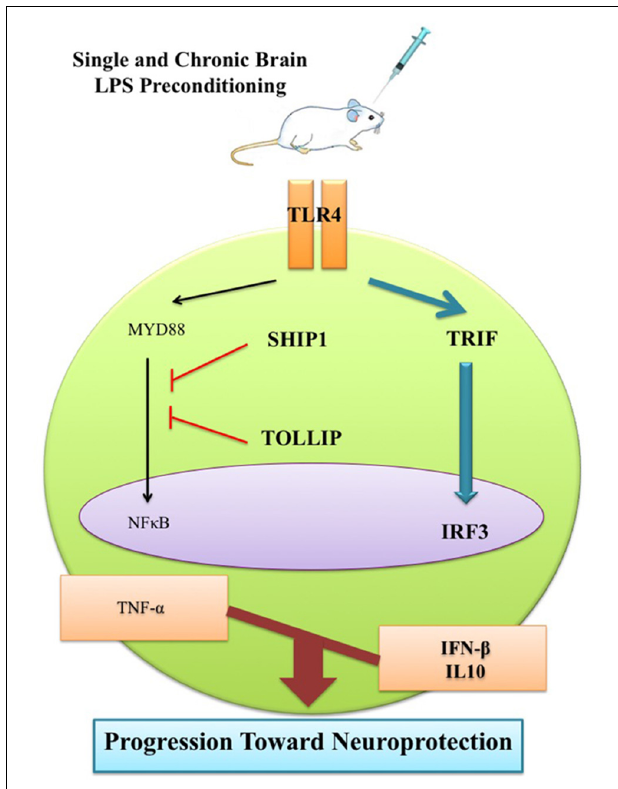
FIGURE 11 | Schematic representation of gene expression pattern related to TLR4 signaling pathway following epileptic seizure. Low dose of LPS reprograms TLR4 signaling in response to subsequent brain injury. This reprogrammed response that is reminiscent of neuroprotection comes with reduction of NF κ B activity to reduce pro-inflammatory mediators, up-regulation of IRF3 activity, and enhancement in production of anti-inflammatory/type I IFN associated genes in the LPS-preconditioned animals following brain